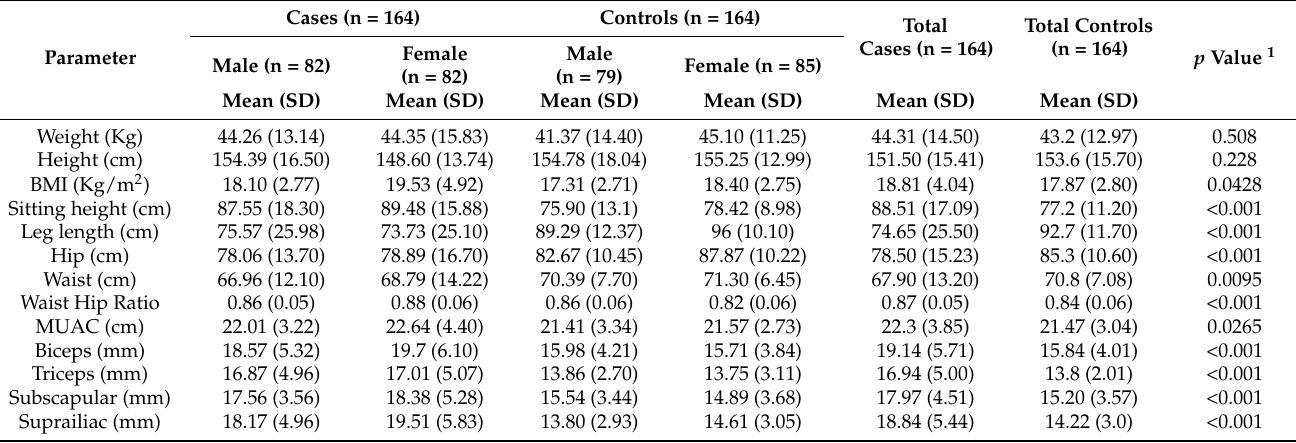
Table 3. Anthropometry.